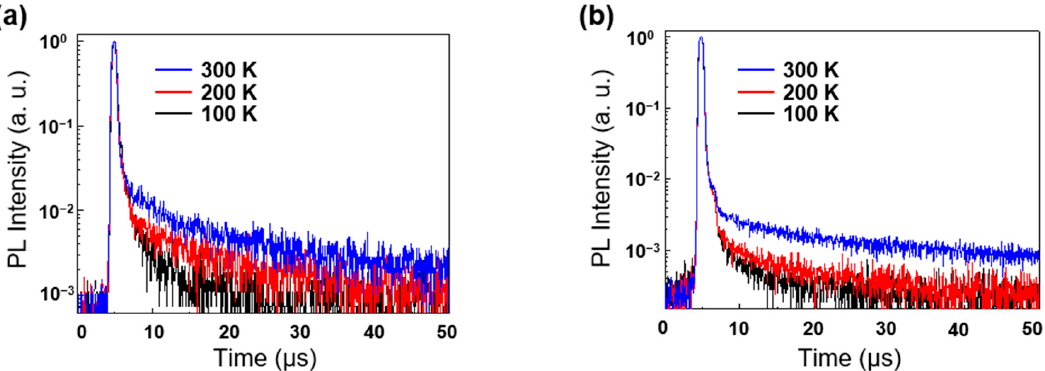
Figure 3. Temperature-dependent transient PL decay curves of ( a ) 12 wt% ICzCN :PPF and ( b ) ICzCYP :PPF doped films. Table 2. Photophysical properties of 12 wt% ICzCN :PPF and ICzCYP :PPF doped film.